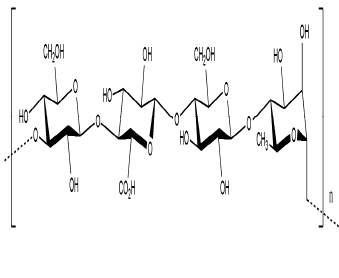
Figure 4. The primary structure of gellan gum [74].